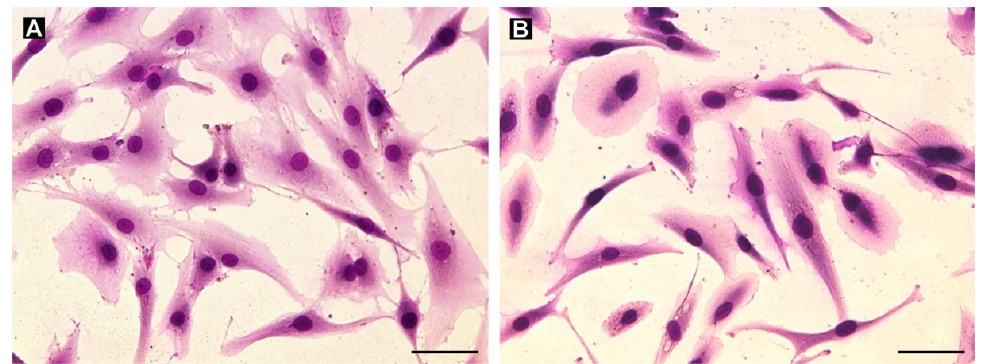
Figure 4. Examples of the morphology of cell lines derived from denosumab-treated ( A , cell line GCTB8) and untreated ( B , cell line GCTB7) samples as visualized using Giemsa staining. Mainly mononuclear (stromal) cells with fibroblast-like morphology were derived from the tumor tissues. Bar, 100 µm.